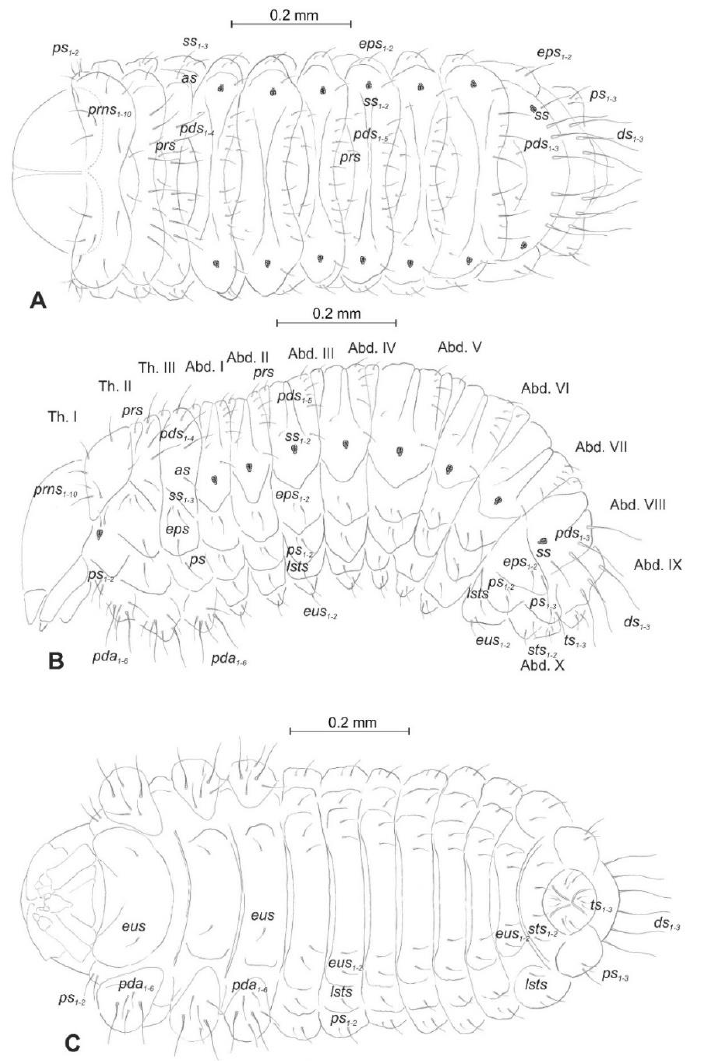
Figure 5. Euryommatus mariae mature larva, habitus, and chaetotaxy. ( A ) Dorsal view; ( B ) lateral view; ( C ) ventral view (Th. I–III—thoracic segments 1–3, Abd. I–X—abdominal segments 1–10,